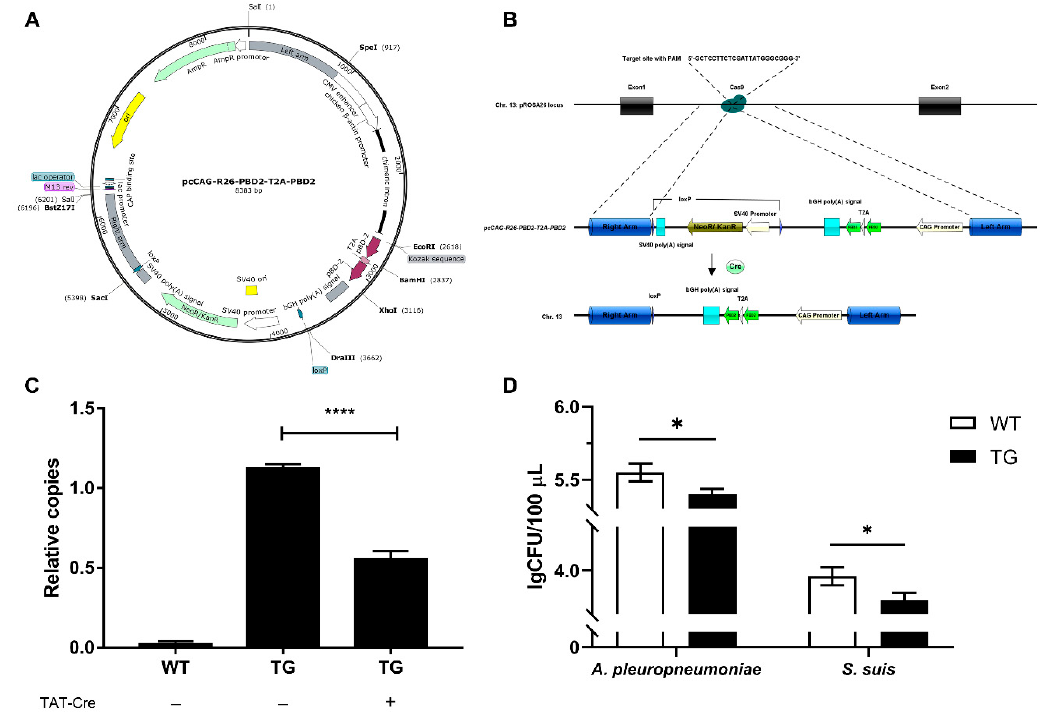
Figure 1. Site-specific pbd-2 knock-in at the porcine Rosa26 ( pRosa26 ) locus. ( A ) Map of the donor plasmid pcCAG-R26-PBD2-T2A-PBD2 for the site-specific pbd-2 knock-in. ( B ) Scheme for marker-free targeted pbd-2 integration in porcine fetal fibroblasts (PFFs) via CRISPR / Cas9-mediated homology-directed repair. The floxed selectable marker gene (SMG) was removed after treatment of Cre recombinase. ( C ) Relative copy number of the SMG neoR in wild-type (WT) PFFs, transgenic (TG) PFFs and Cre-recombinase-treated TG PFFs. ( D ) The bactericidal activities of cell culture supernatants of WT PFFs and TG PFFs on Actinobacillus pleuropneumoniae and Streptococcus suis quantified by bacterial counting. Data are presented as mean ± SD and are plotted from three independent experiments. * p < 0.05, **** p < 0.0001, unpaired one tailed Student ′ s t -test.